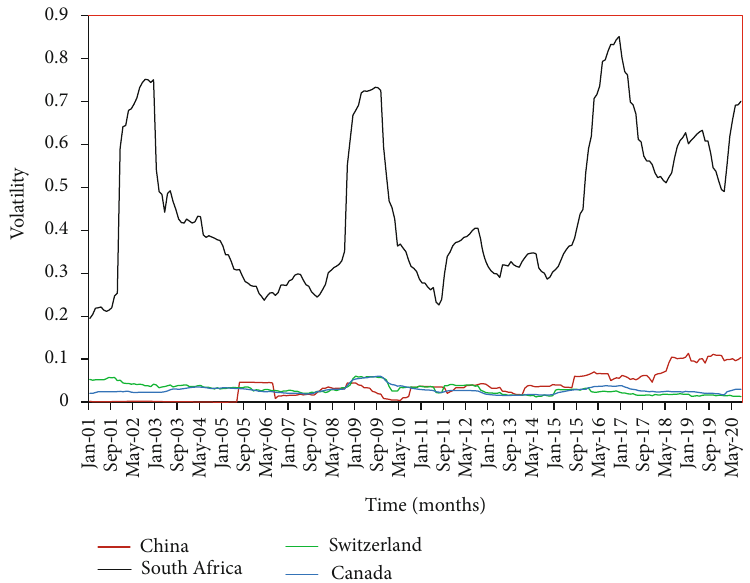
Figure 4: Trend analysis plots of the moving volatilities in exchange rate by country. Source: FRED, 2000-2020.